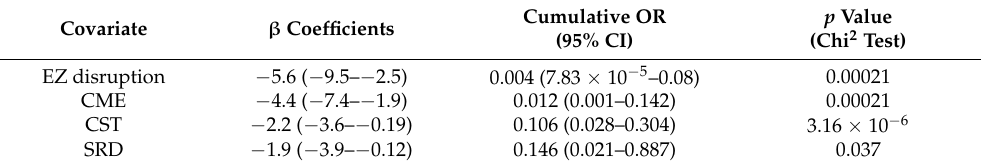
Table 2. The significant correlations between VA and morphological characteristics. CME: cystoid macular edema, SRD: serous retinal detachment, CST: central subfield thickness, EZ: Ellipsoid